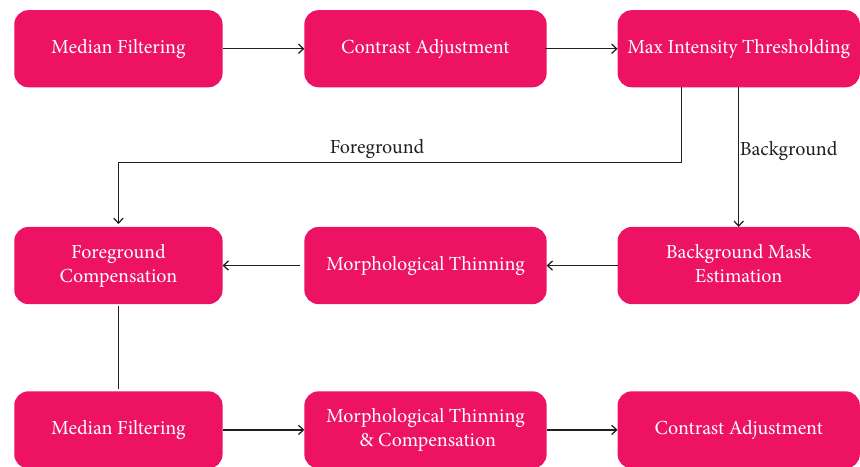
Figure 4: Proposed preprocessing flowchart for